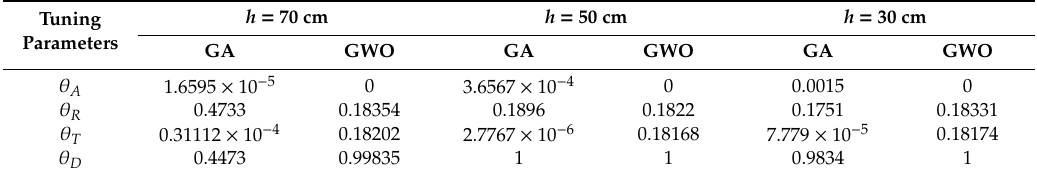
Table 8. RTD-A parameters for level control of the conical